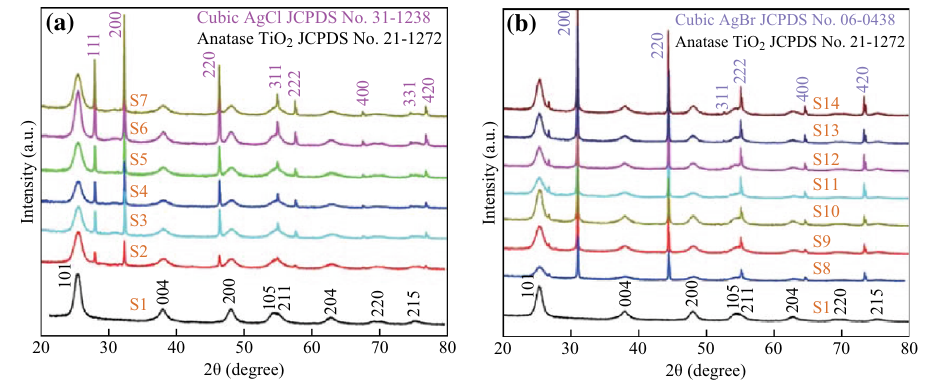
Fig. 1 XRD patterns of a the Ag–AgCl@TiO 2 NPAS samples and b Ag–AgBr@TiO 2 NPAS samples